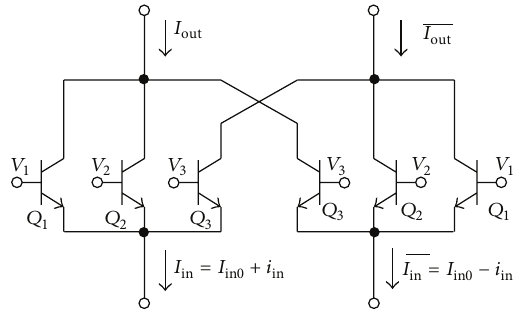
Figure 5: Comparison of current gain and DC current output I MT, CS and HCS cell.